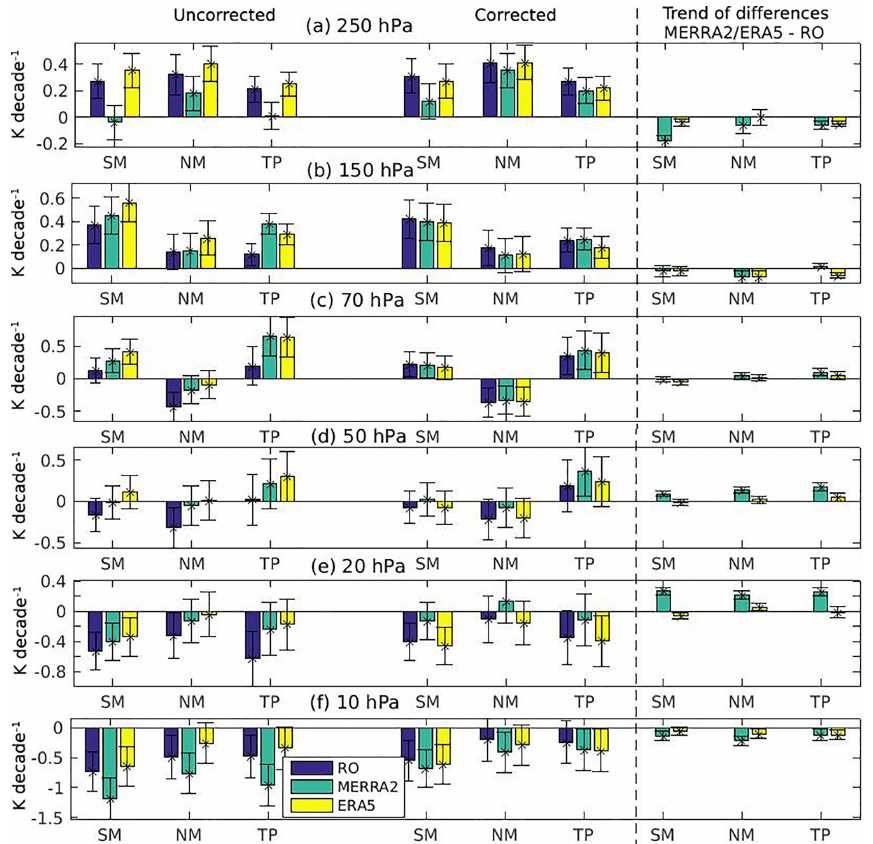
Figure 12. Estimated temperature trends in K per decade in different regions (SM: 25–45 ◦ S; NM: 25–45 ◦ N; TP: 10 ◦ S–10 ◦ N) from 2002 to 2017. (a–f) Trends in corrected and uncorrected data sets at 250, 150, 70, 50, 20 and 10hPa. Trends based on the differences of time series between MEMRRA2/ERA5 and GNSS RO are also shown to the right of the figure. Error bars represent 95% confidence